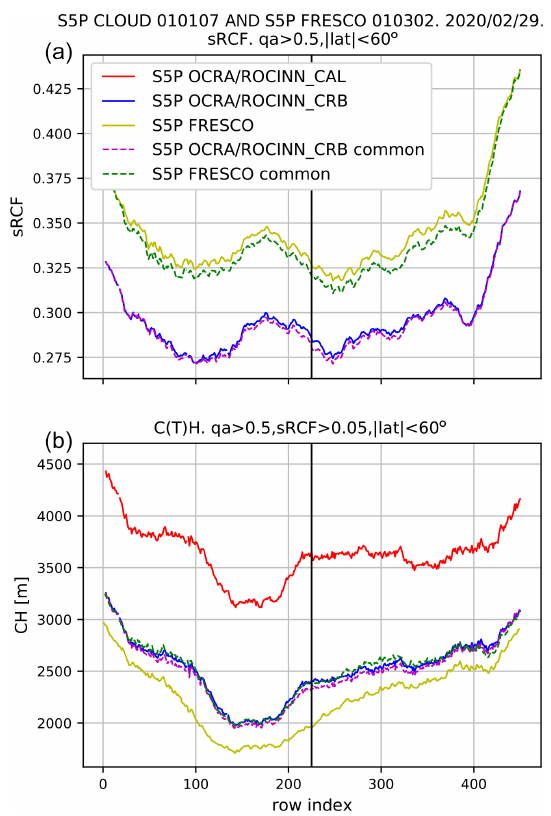
Figure 5. (a) Mean pixel value per row index of sRCF of S5P OCRA/ROCINN_CRB and S5P FRESCO. Only pixels with qa_value > 0 . 5 are selected. Note that FRESCO pixels are mapped to those of OCRA/ROCINN. The label “common” indicates that the common subsets of valid pixels are taken. The black vertical line indicates the middle row. Note that index 0 corresponds to the westernmost pixel. (b) C(T)H of S5P OCRA/ROCINN_CAL, S5P OCRA/ROCINN_CRB, and S5P FRESCO. Only pixels with qa_value > 0 . 5 and sRCF > 0 . 05 are selected. Other conventions as in panel (a)